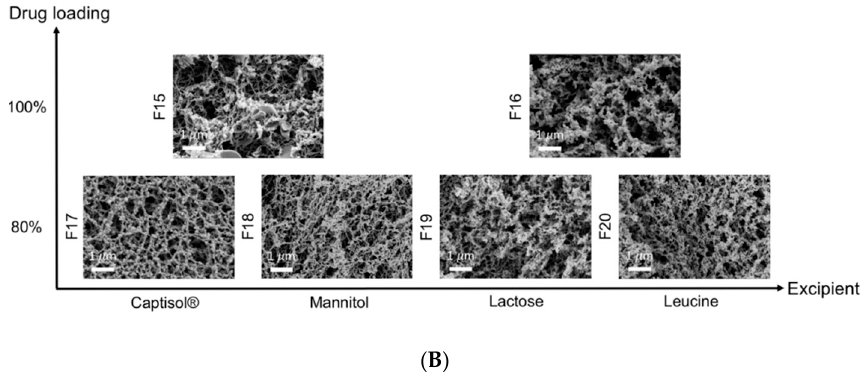
Figure 1. Brittle matrix particle morphology of TFF remdesivir compositions; ( A ) formulations prepared in acetonitrile/water (50/50) co-solvent mixture; ( B ) formulations prepared in 1,4-dioxane/water (50/50) co-solvent mixture.